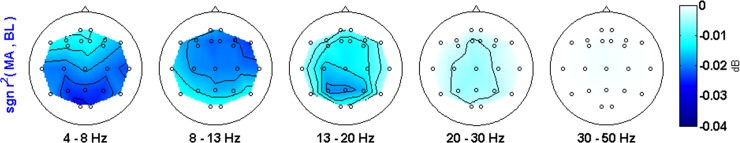
Signed r2-values (sgn r2) in the θ- (4–8 Hz), α- (8–13 Hz), low β- (13–20 Hz), high β- (20–30 Hz), and γ-band (30–50 Hz).The colorbar indicates the level of sgn r2 ranging from -0.04 to 0 dB. Note that the lower value (dark blue) indicates better separability than the higher value (light blue). Considering only frontal areas used for data analysis, the highest separability is shown in the α-band; moderate separability is shown in the θ- and low β-band.